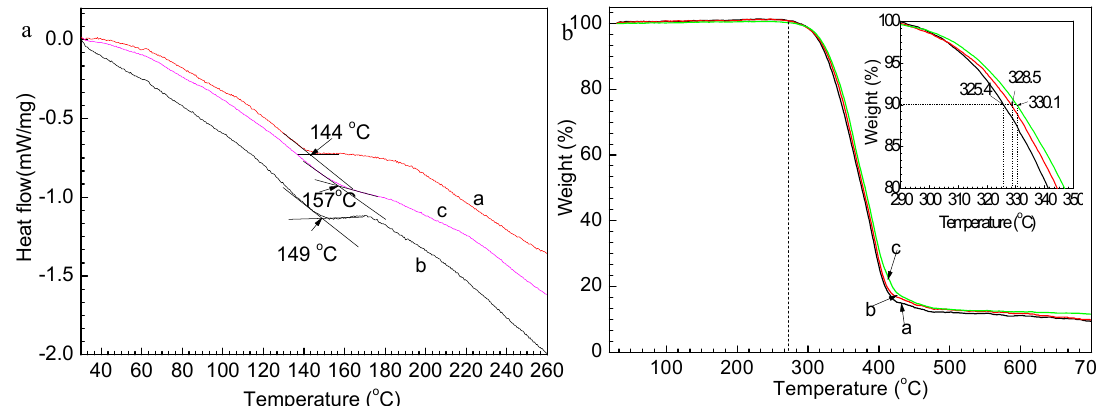
Figure 5. DSC ( a ) and TG ( b ) measurements of pure TPU (curve a), composites films containing graphene of 0.5 wt% (curve b) and 1.5 wt% (curve c).